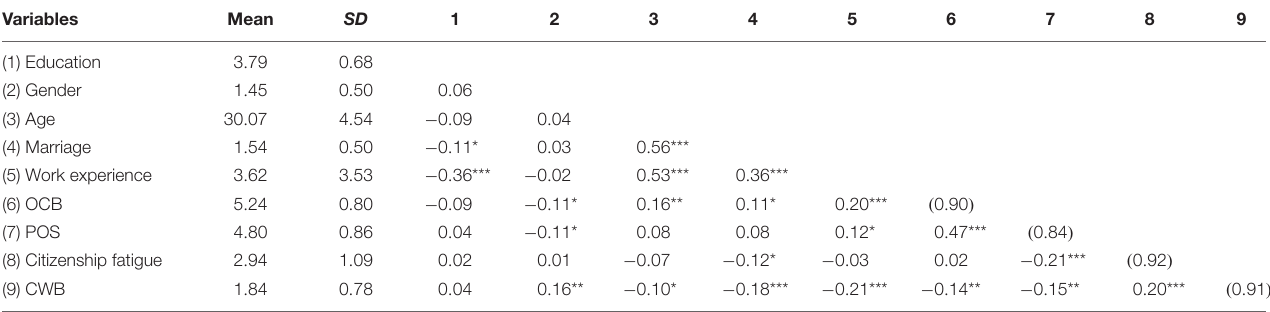
TABLE 1 | Means, standard deviations and correlations.